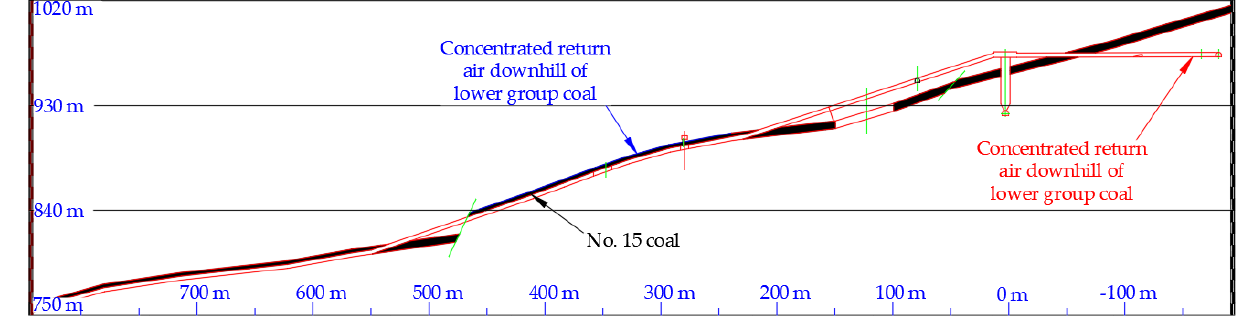
Figure 1. Relationship between coal seam 15 # and the preparation roadway.